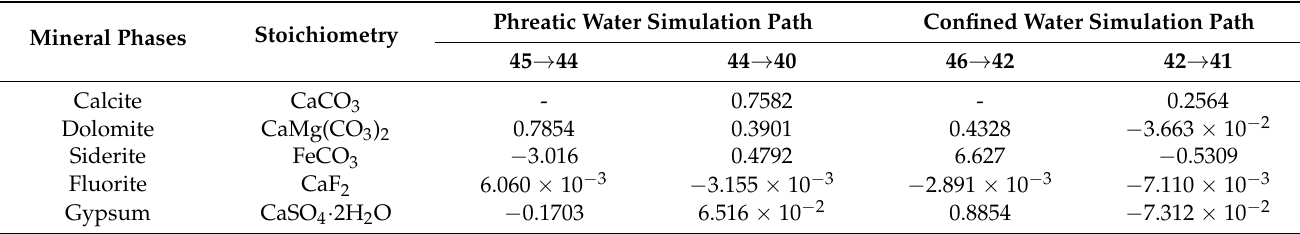
Table 7. Mass exchange results of water samples along simulated paths (mmol · L − 1